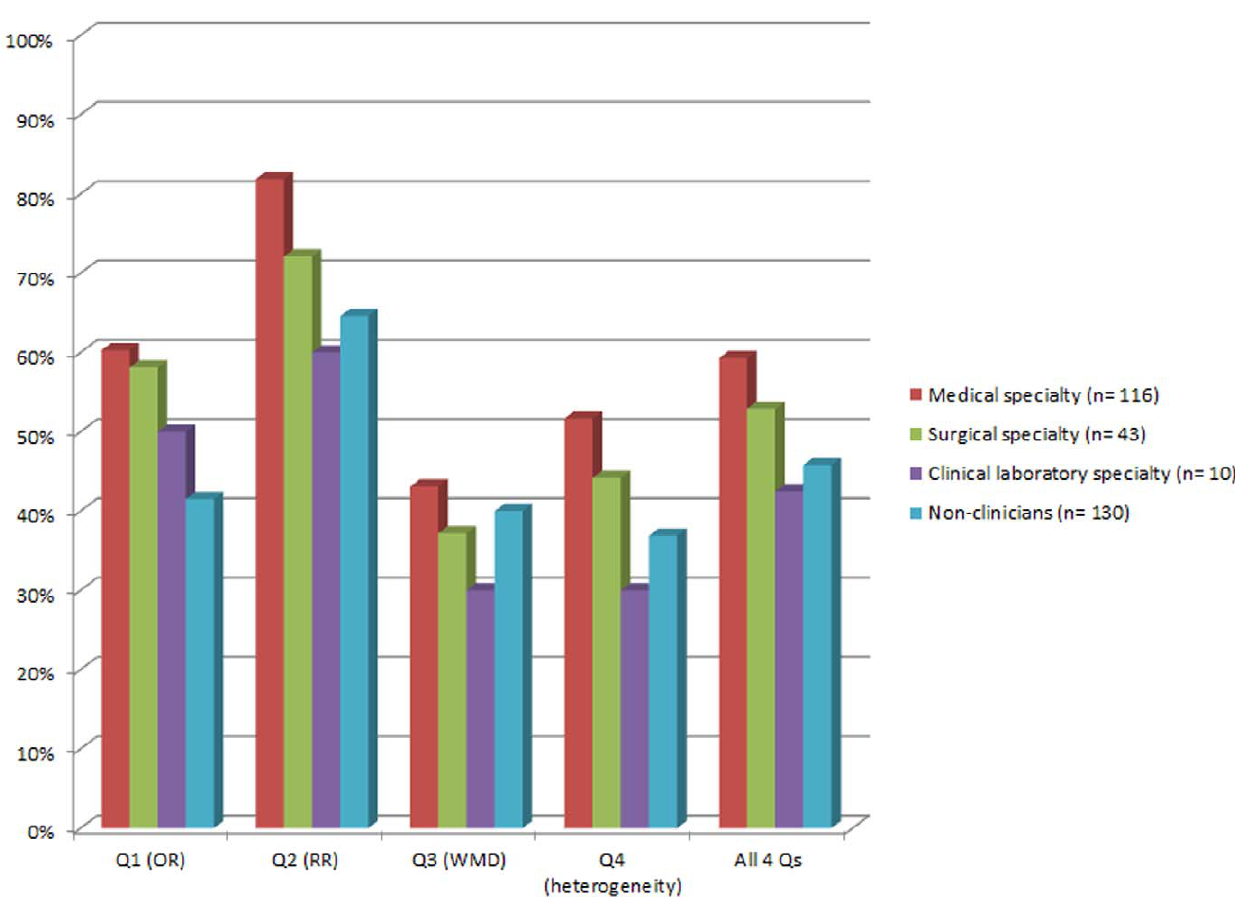
Figure 2. Percentage of correct responses to each question, stratified by specialty. Clinicians had more correct answers than non-clinicians (mean score 6 standard deviation: 2.27 6 1.06 versus 1.83 6 1.14, p , 0.001). [Q=Question; OR=Odds Ratio; RR=Risk Ratio; WMD=Weighted Mean Difference].